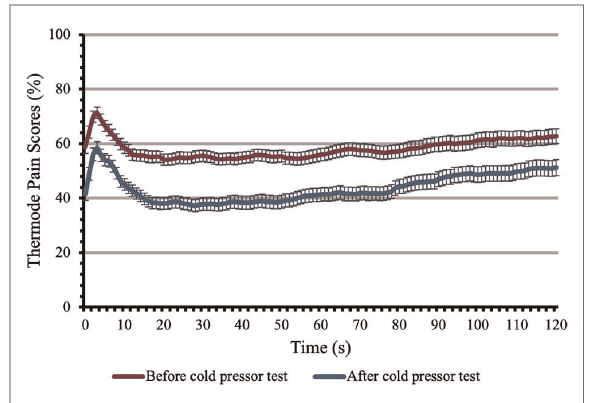
FIGURE 4 Inhibitory conditioned pain modulation. This fi gure shows the pain perception of participants to the heating thermode before and after the conditioning stimulus. Pain perception was evaluated during both tests on a scale of 0 to 100 for 120 s. Each time point shows the